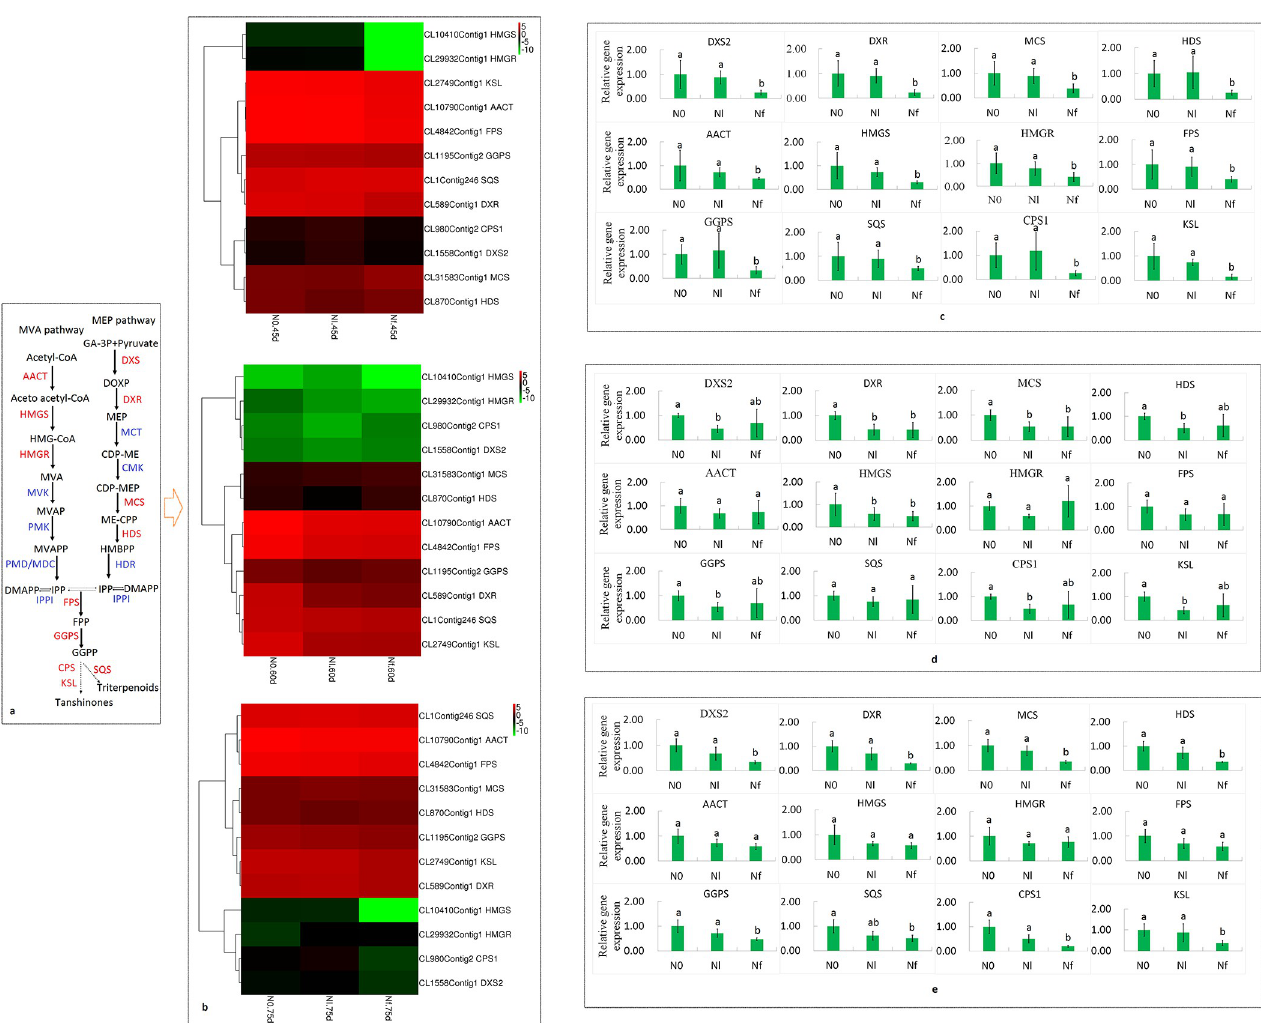
Fig 10. Proposed terpenoid biosynthesis pathways in S . miltiorrhiza (a). Heat map describing the expression profile of tanshinone biosynthesis-related genes from the MEP and MVA pathways in the roots of S . miltiorrhiza grown under low and full-nitrogen levels in N0, Nl, and Nf at 45, 60, and 75 days after transplanting (DAT) (b). qRT-PCR validation of differentially expressed genes in N0, Nl, and Nf at 45 (c), 60 (d), and 75 (e) DAT. Different letters represent significant differences between treatments (P < 0.05).